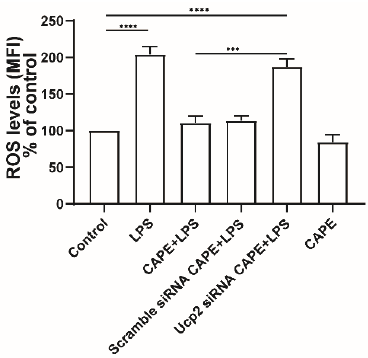
Figure 5. CAPE is nontoxic and can prevent peroxide-induced cell death. ( A – C ). Cell viability was measured by an LDH assay after pre-incubation with different concentration of ( A ) 4HNE; ( B ) CAPE; ( C ) caffeic acid for 2 h (black symbols) or 24 h (red symbols). Data are expressed as individual points as well as mean ± SD. The 24 h group statistical differences are shown in red (n = 3, * p < 0.05, ** p < 0.01, *** p < 0.001, **** p < 0.0001); 2 h group statistical differences are shown in black (n = 3, * p < 0.05, ** p < 0.01, *** p < 0.001. ( D – F ). ARPE19 cells were treated for 12 h with different concentration of compounds without (black curve) or with (red curve) t- BHP (200 µ M). ( D ) 4HNE; ( E ) CAPE; ( F ) caffeic acid. The decrease in cell survival induced by t-BHP was completely blocked by CAPE. 4-HNE, and caffeic acid gave smaller improvements in cell survival and required higher concentrations. Data points represent mean ± SD, n = 3. Error bars are only shown when they are larger than the data point symbols. Adapted from Reference [60].